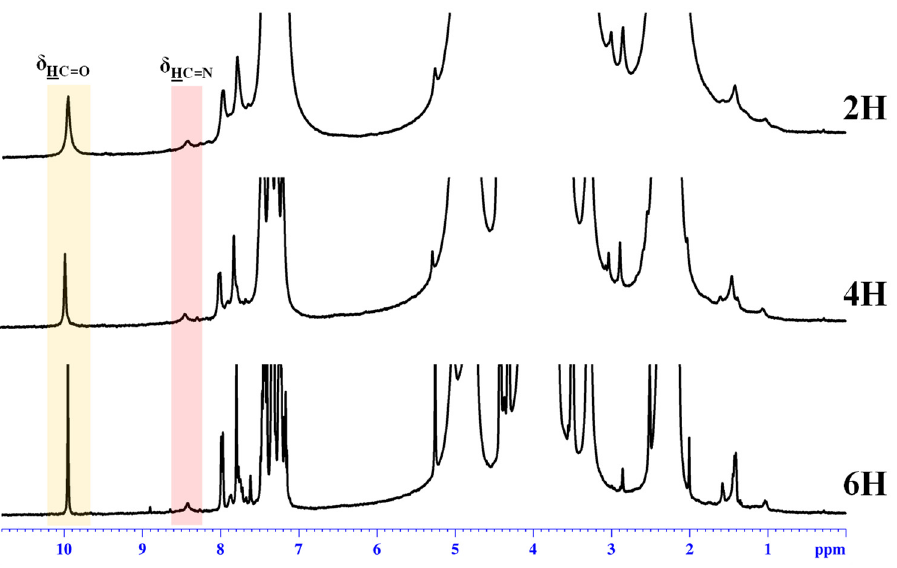
Figure 1. 1 H-NMR spectra of the hydrogels recorded in D 2 O/acetone-d 6 (1/1.3) at 25 °C .